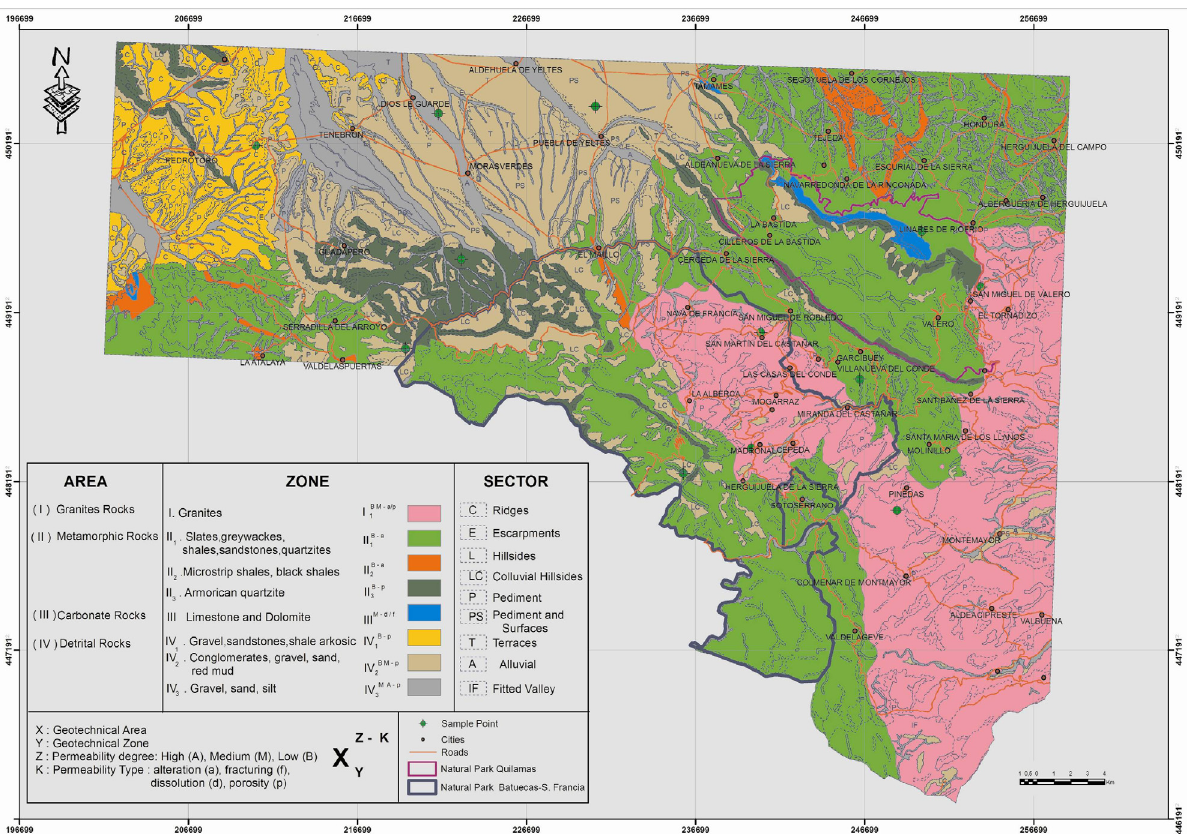
Figure 5. Geotechnical